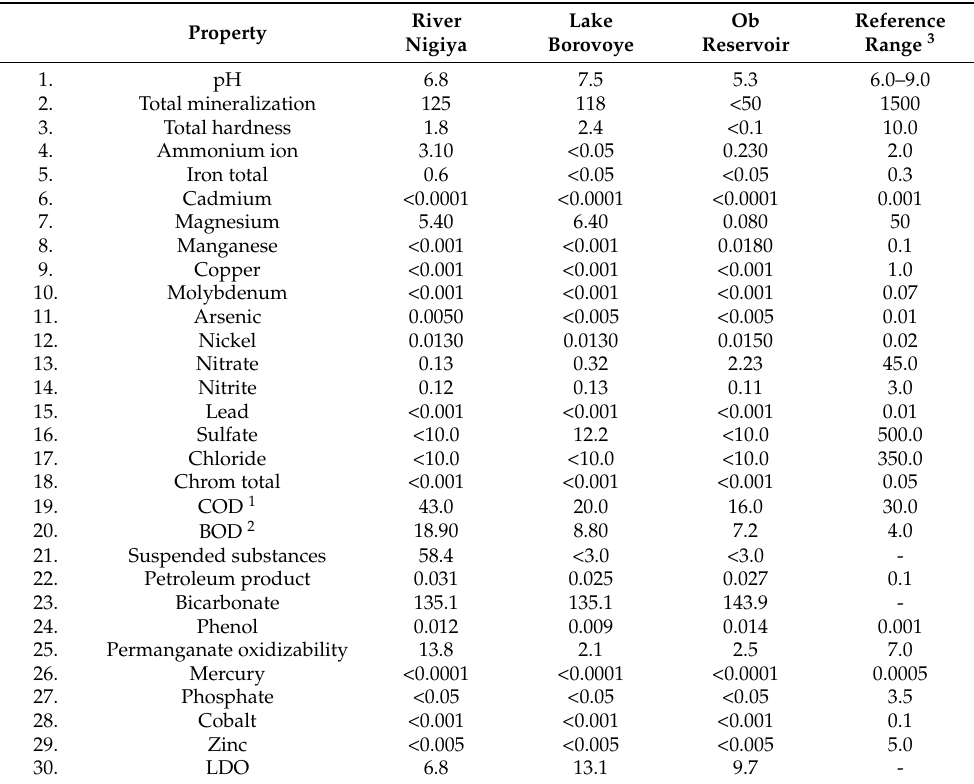
Table 1. Biochemical analysis of water samples from the Nigiya River, Lake Borovoye, and the Ob Reservoir. All data (except pH) are given in units of